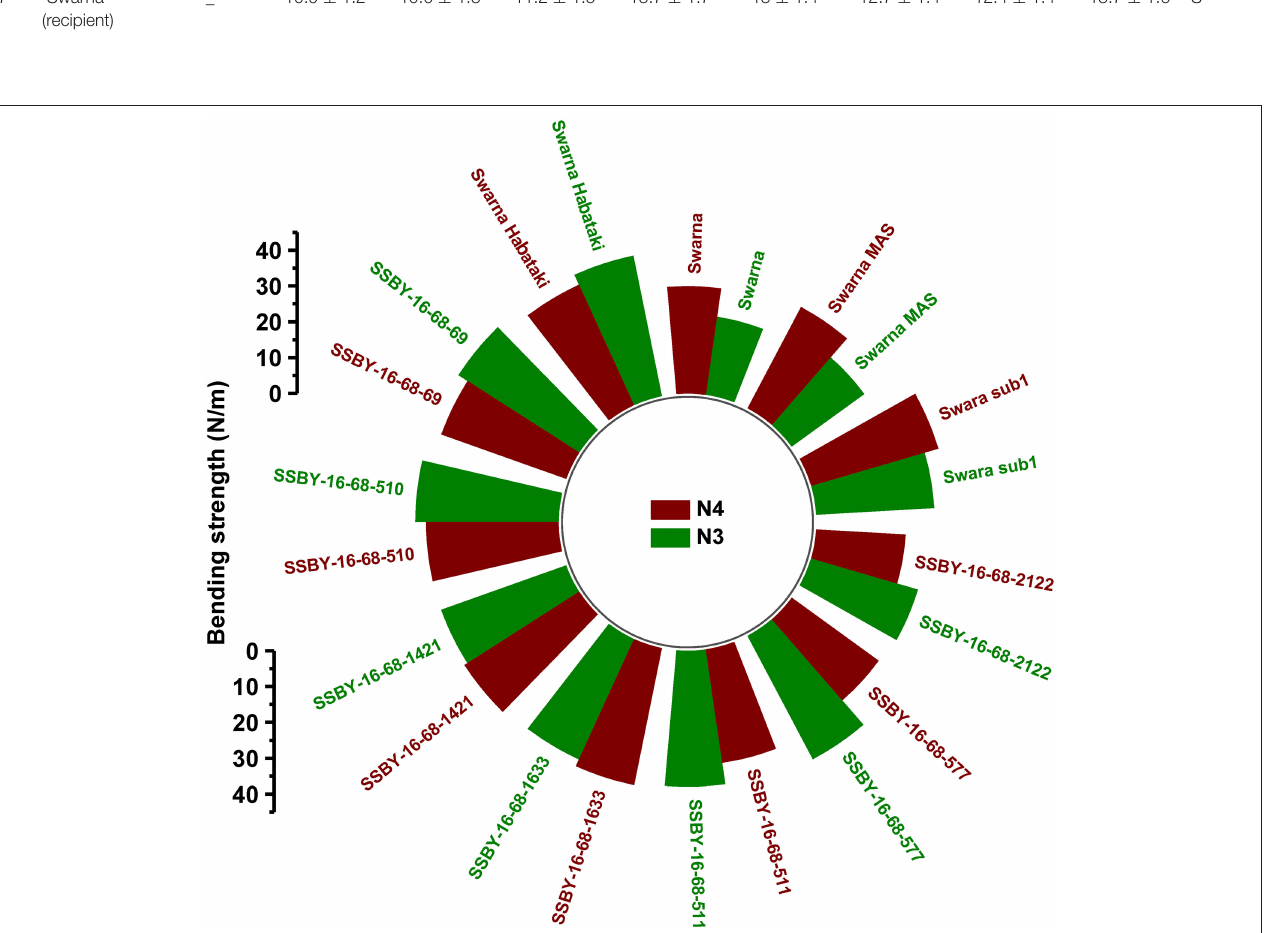
FIGURE 7 | Bending strength of internode N3 and N4 of seven pyramided lines and four parental lines.